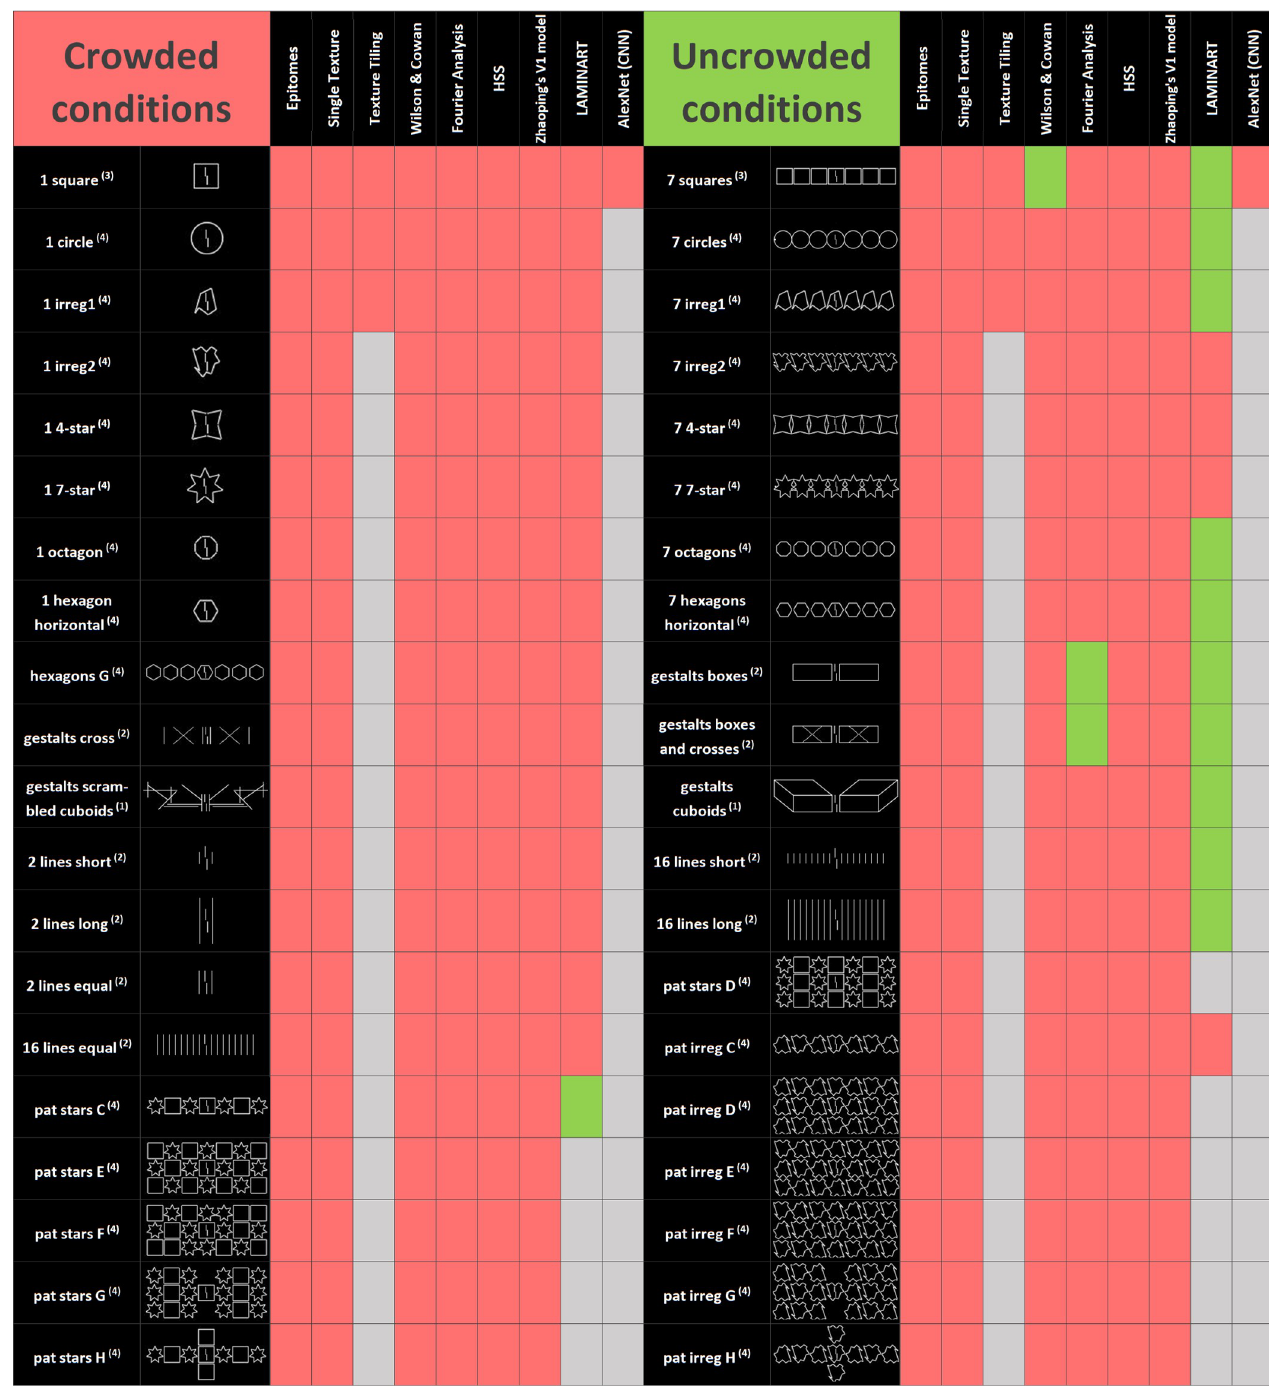
Fig 14. Summary of results. Results for all models (columns). In black, the left panel displays all crowding stimuli and the right panel displays all uncrowding stimuli (i.e., better performance when extra elements are added to the crowded condition) as observed in human data (rows). Superscript numbers indicate which publication the results are taken from (1: Sayim, Westheimer & Herzog [17]; 2: Manassi et al. [11]; 3: Manassi, Sayim & Herzog [19]; 4: Manassi et al. [15]). Red indicates that the model predicts crowding, green indicates uncrowding and gray indicates that we did not run the model on the stimulus. A perfect model would have only red in the left half of the table and only green in the right half. Only the LAMINART is capable of producing uncrowding consistently. Fourier and the Wilson-Cowan network produce uncrowding, but suffer from overfitting (see discussion). For these two models, we provide the results for the best parameters. For example, the Wilson and Cowan with different parameters can explain the lines category but then it cannot explain the squares and irregular1 categories.